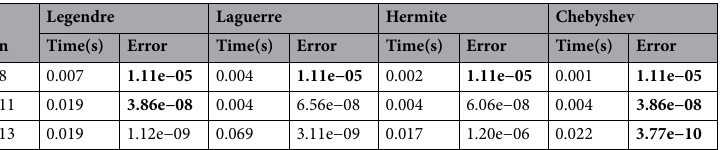
Table 7. Comparision of maximum relative error for Example 6.4 with different numbers of neurons. Significant values are in